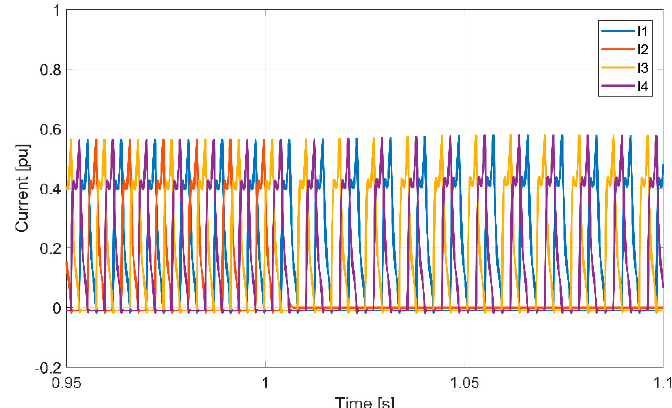
Figure 10. Motor winding currents of the SRM at 1200 rpm in normal condition and open-circuit failure of power device S 1 B (simulation result).